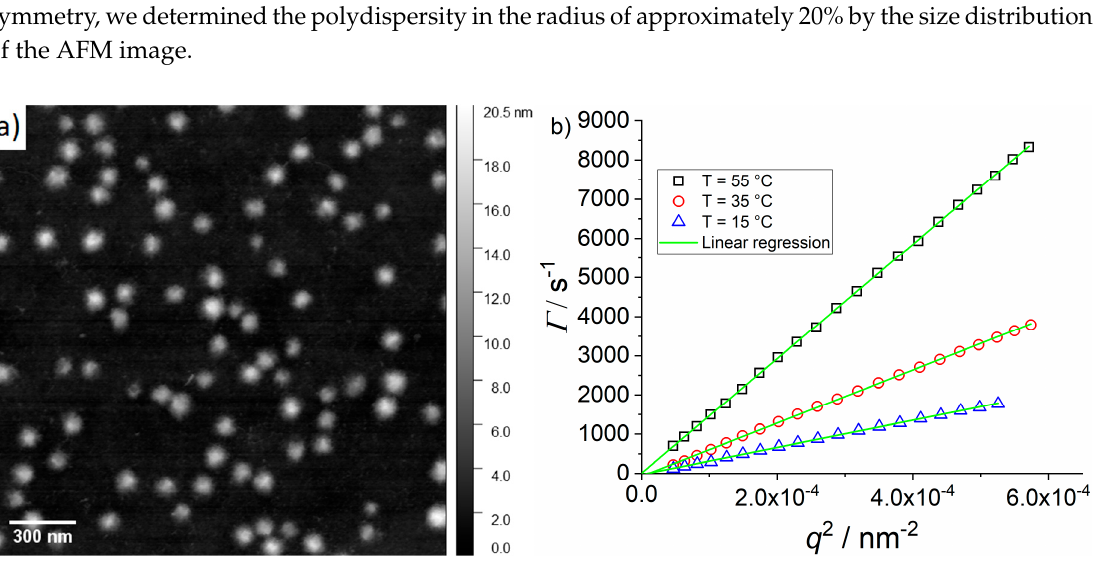
Figure 1. PCS and AFM measurements of a H-pNIPMAM microgel. ( a ) Atomic fore microscopy image of dried pNIPMAM microgels on a silicon substrate. ( b ) The Γ vs. q 2 of an angle dependent PCS measurement in water from 30° to 130° at 15, 35, and 55 °C. The Y-Axis intercepts are − 32, − 75, and 5 s − 1 , respectively.